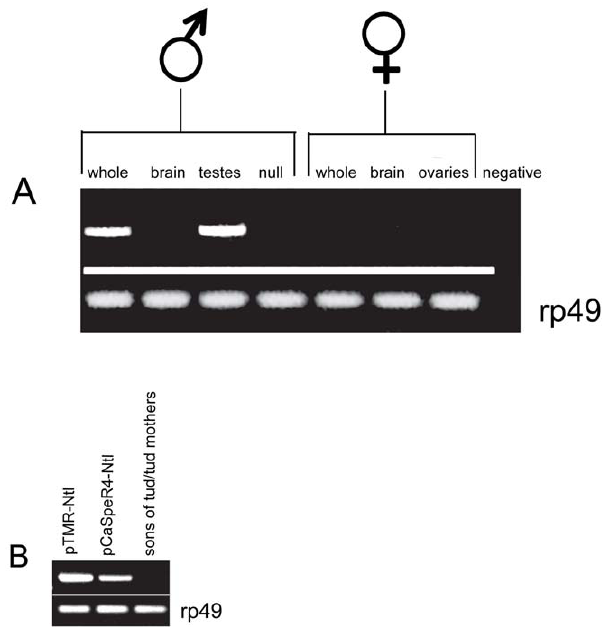
Figure 3. Ntl expression is testis specific and limited to the germline. A) From the left: Ntl RT-PCR products from wt whole males, wt male heads, wt male testis, 129A whole male; Ntl RT-PCR products from wt whole females, wt female heads and wt female ovaries. The last lane is a negative control without RNA. B) Ntl RT-PCR products from Ntl/ Ntl mutant males carrying a pTMR- Ntl cDNA construct (Lane 1; yw; Ntl 129A /Ntl 129A ; pTMR-Ntl1/TM3,Sb ) and a genomic pCaSpeR4 construct (Lane 2; yw; Ntl 129A /Ntl 129A ; pCaSpeR 4- Ntl1/ TM3,Sb ). Lane 3: Ntl RT-PCR product from testes of male offspring of tud/tud females, which lack germ